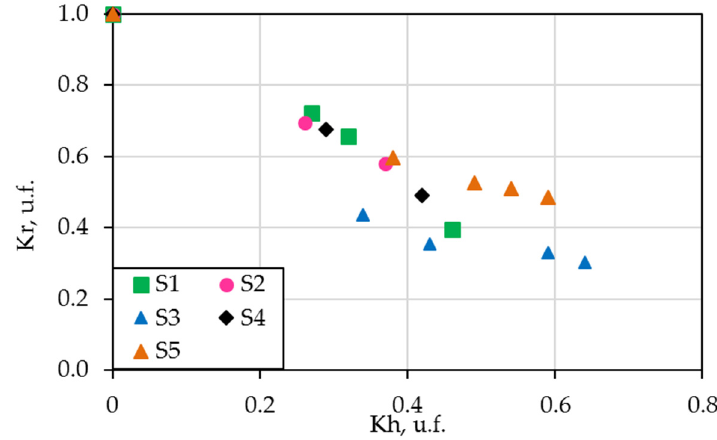
Figure 6. Relative gas permeability ( K r ) as a function of hydrate coefficient.